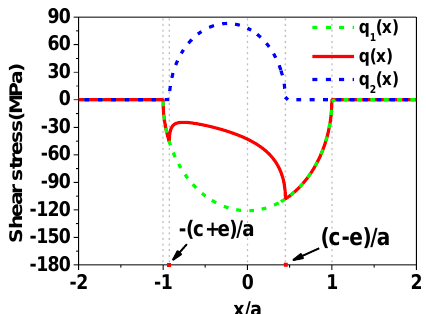
Figure 3. Shear stress distribution at the contact interface.